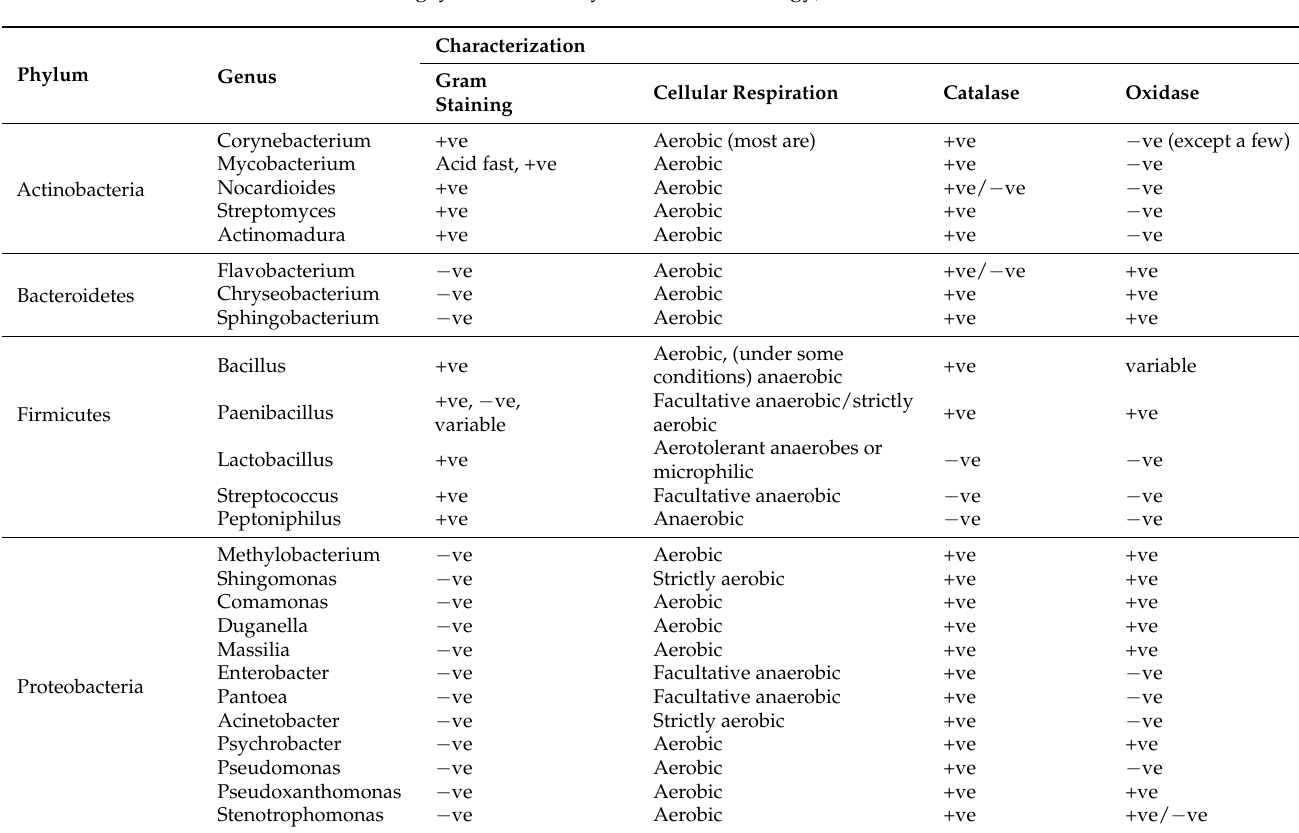
Table 2. Major bacterial genera found in the bee bread and bee pollen and their biochemical charac- terization in most of the cases of the genus (biochemical properties of bacterial genera were obtained from Bergey’s manual of Systematic